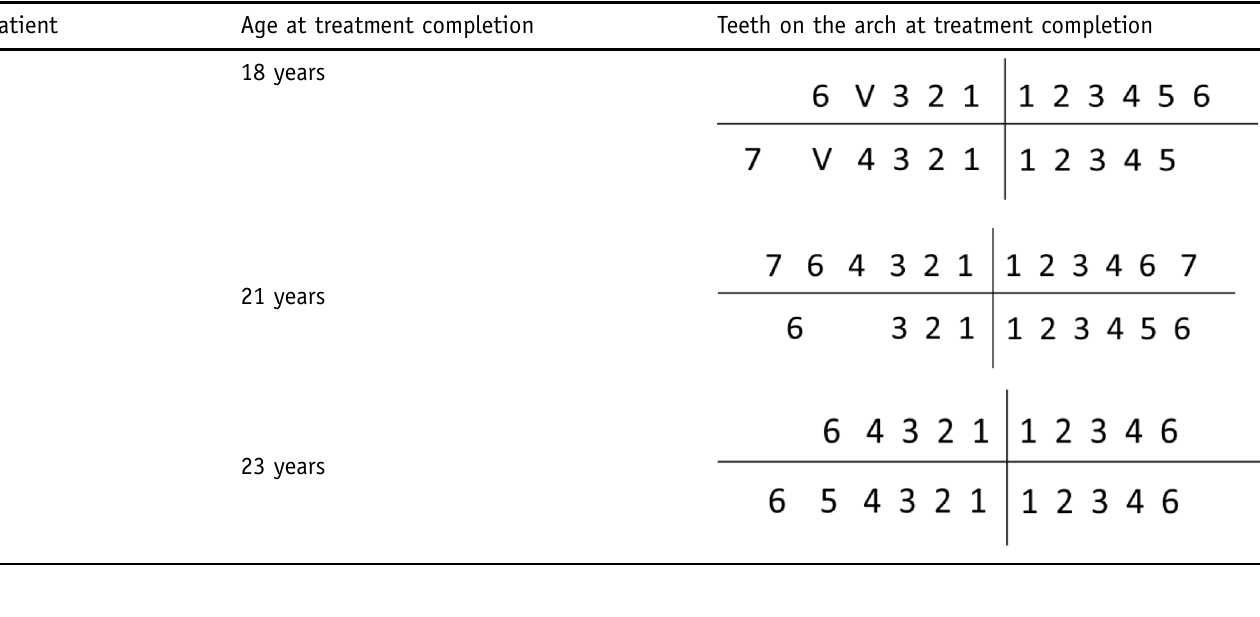
Table II. Age of patients and teeth on the arch at the end of treatment (temporary teeth are presented in Roman numerals, and permanent teeth are presented in Arabic numerals).